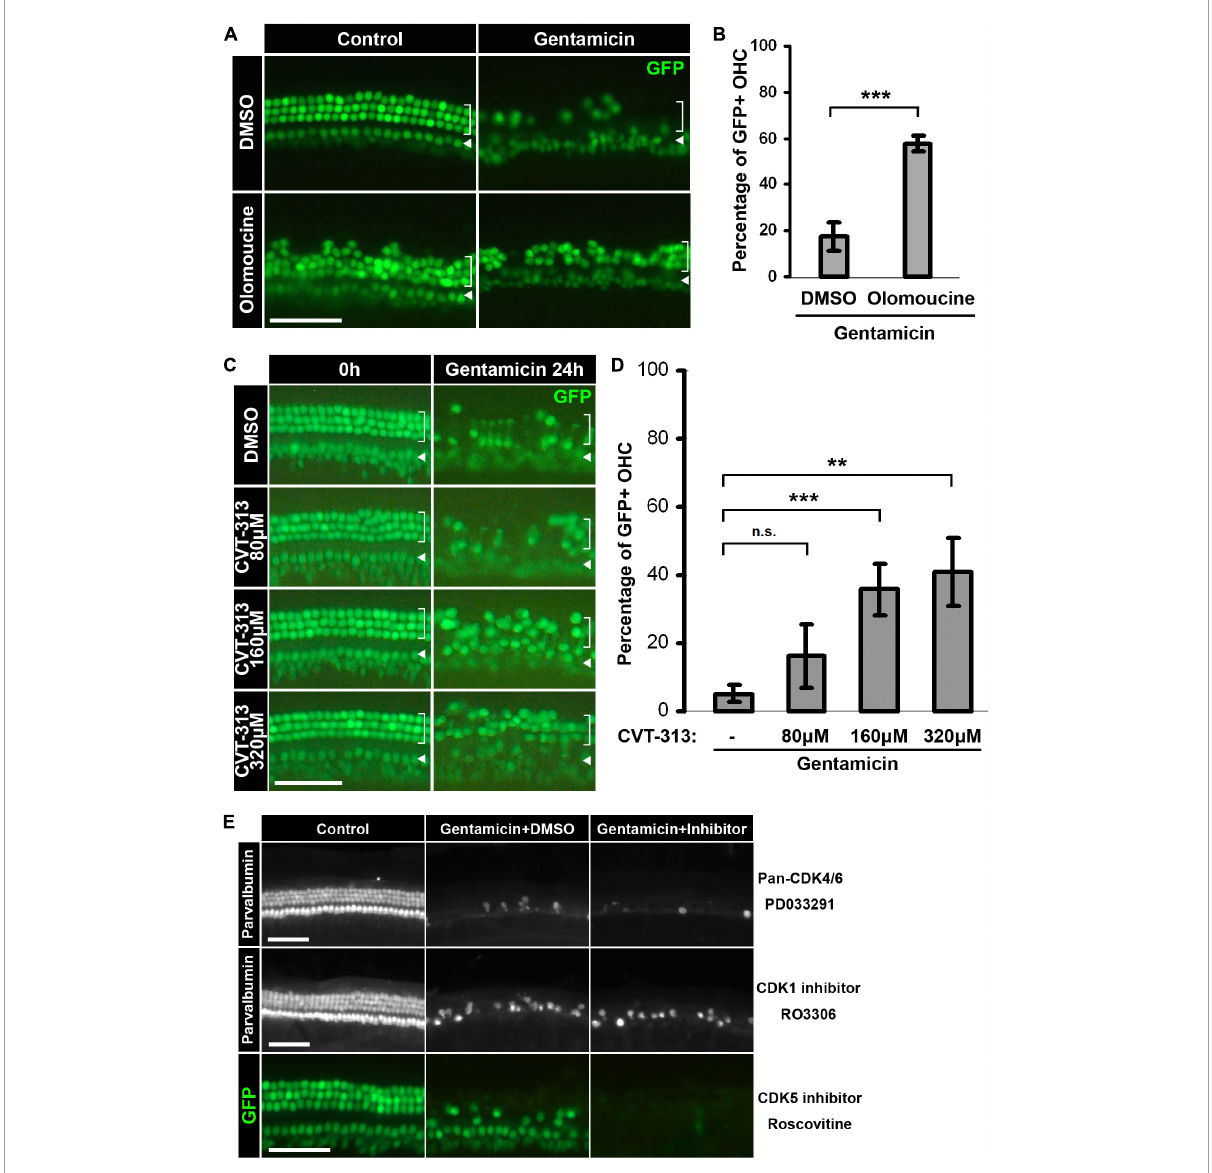
FIGURE2 Inhibition of CDK2 activity confers protective effects against gentamicin ototoxicity. (A) Pan-CDK1,2,5 inhibitor Olomoucine protects hair cells from gentamicin-induced loss. Representative images of the base of cochleae are shown. Gentamicin treatment induces massive hair cell loss at 24-h, but more GFP-positive hair cells survive when Olomoucine is present. (B) Quantification of the percentages of GFP-positive outer hair cells in the base of the organs treated by gentamicin alone or by gentamicin and Olomoucine. *** p = 0.0018, n = 3. (C) CDK2 specific inhibitor CVT-313 protects hair cells from gentamicin in a dose-dependent manner. Representative images of the base of cochleae at the beginning of treatment and 24-h are shown. The protective effect of CVT-313 correlates with the concentration of CVT-313. (D) Quantification of the percentages of GFP-positive outer hair cells in the base of the organs at 24-h. For 80 µ M CVT-313, adjusted- p = 0.34; for 160 µ M, adjusted- p = 0.0074; for 320 µ M, p = 0.012; n = 3. (E) No protective effect observed for Pan-CDK4/6 inhibitor PD0332991, CDK1 inhibitor RO3306 or CDK5 inhibitor Roscovitine. Hair cells are either labeled by Parvalbumin staining or marked by GFP. Inner hair cells are indicated by arrowheads, and outer hair cells are indicated by brackets. Scale bars, 50 µ m. All surface prep pictures were taken from the base of the cochleae. Error bars in quantification plots represent standard